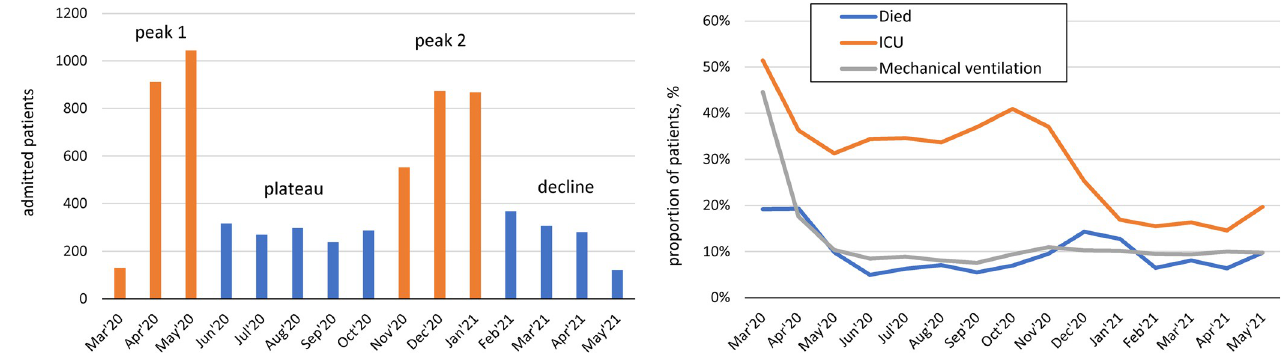
Fig 1. Monthly trends in the number of admissions, resource utilization, and mortality.